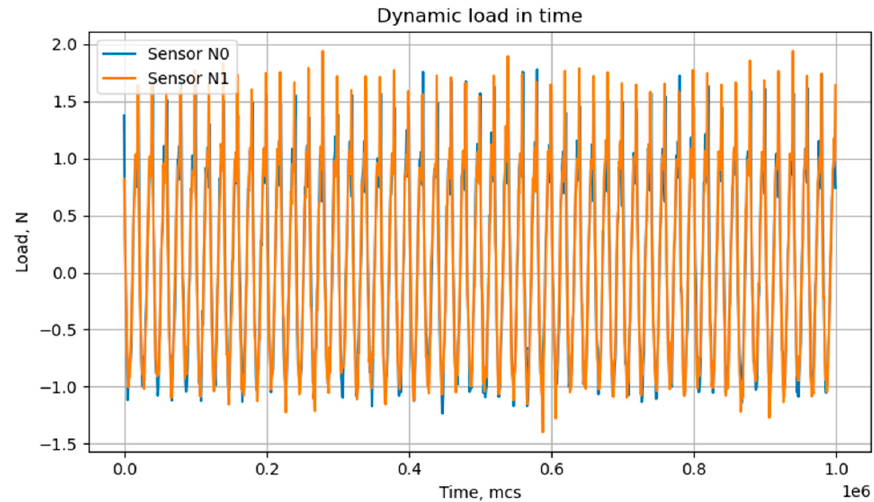
Figure 7. Simulated signal in time arriving at two sensors.